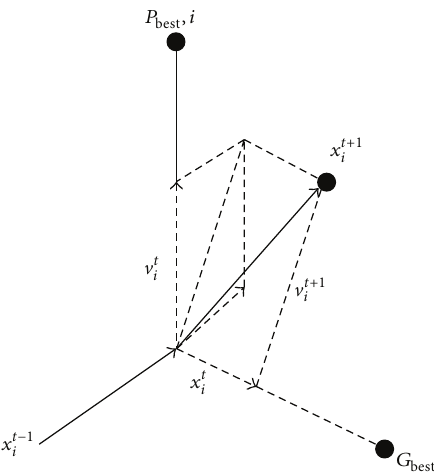
Figure 3: Movement of particles in the optimization process.